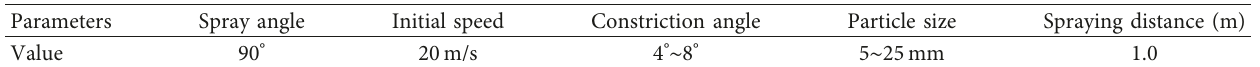
Figure 11: Relationship between rebound rate and spray distance. Table 8: Parameter setting